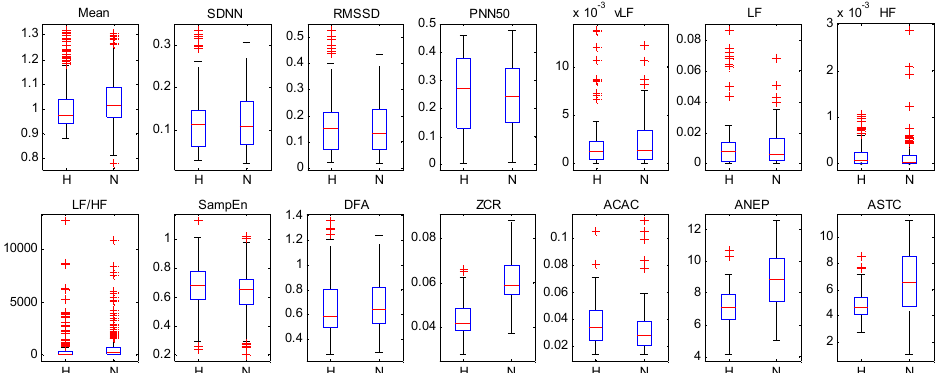
Figure 5. The box diagrams of the extracted features. “H” and “N” represent hypertensive patients and normotensive subjects, respectively.